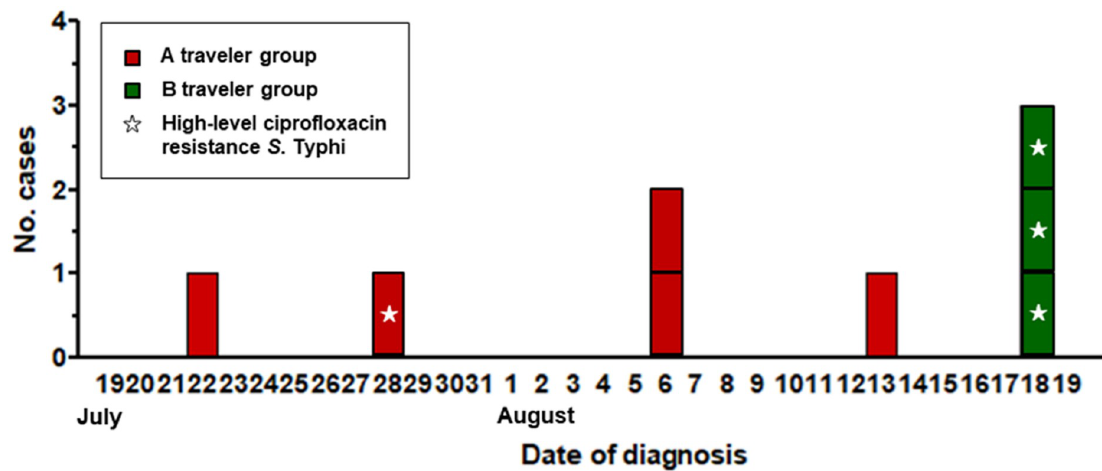
Fig 1. Epidemic curve of the typhoid fever outbreak by date of onset. Traveler group A cases are shown in red, and traveler group B cases are shown in green. Cases of high-level ciprofloxacin-resistant S . Typhi are marked with asterisks.